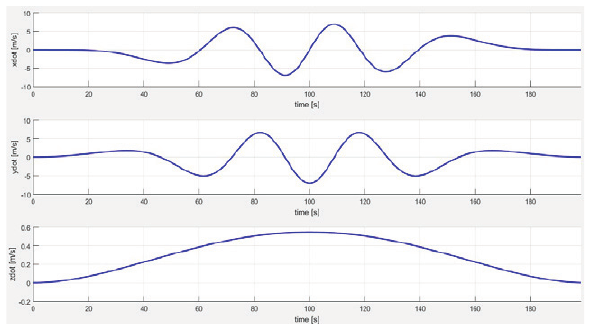
Figure 11. Velocity over the three axes defined by the RPAS